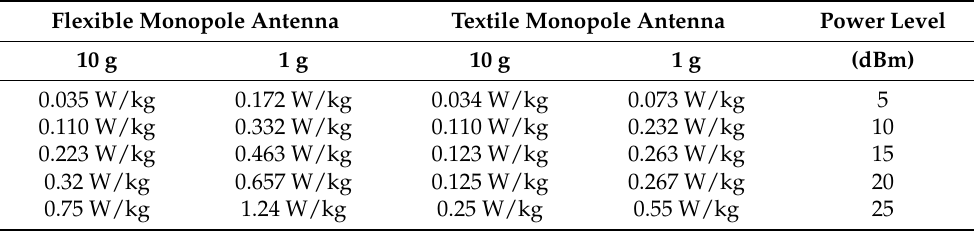
Table 2. Comparison of measured SAR levels for the proposed monopole antenna at 2.45 GHz.